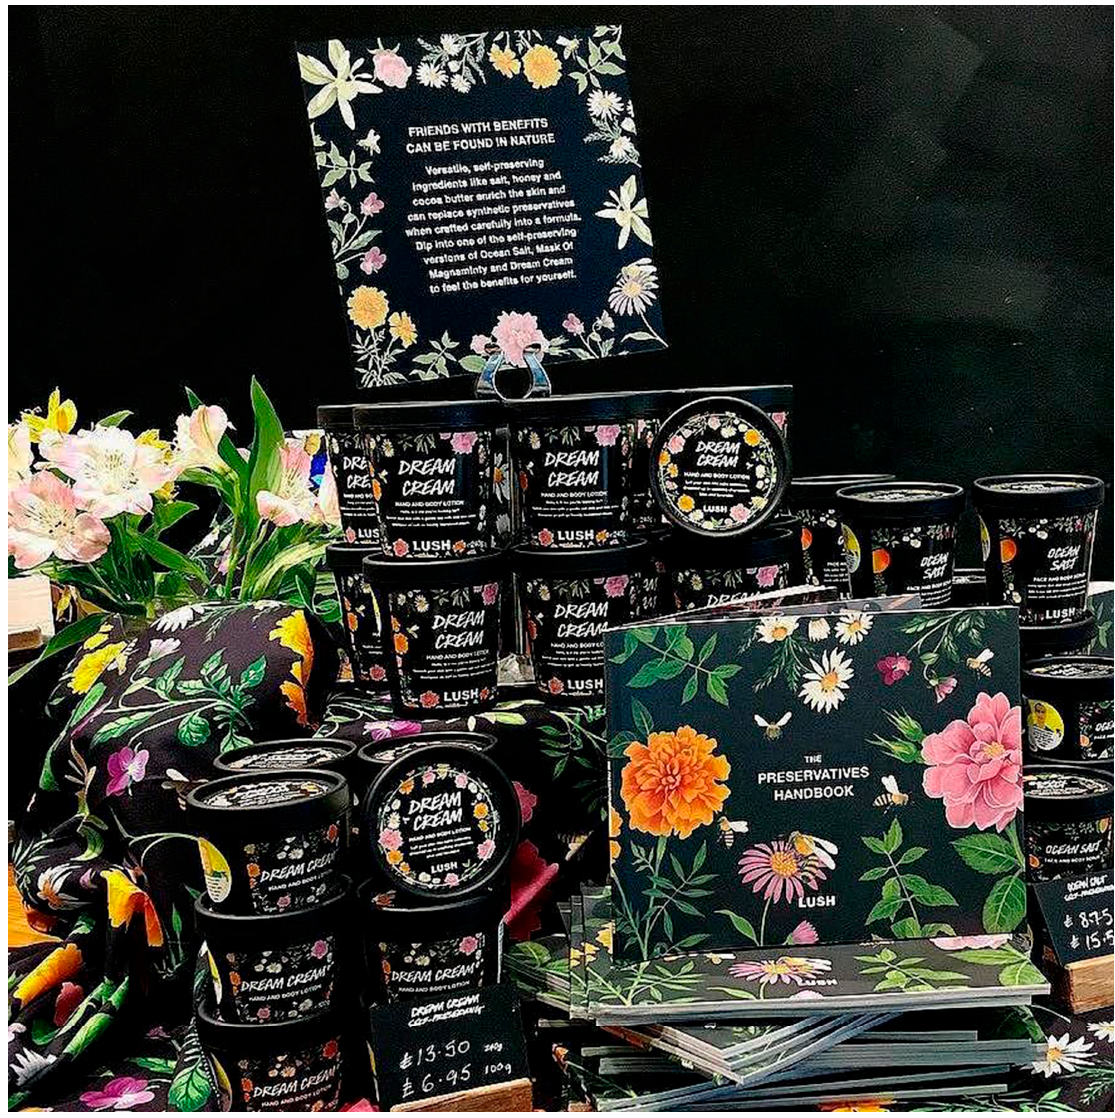
Figure 4. Charlotte Day, LUSH Self preserving campaign , 2017. The graphic designer on her Twitter page, on May 14th, announcing the releasing for new potties with her